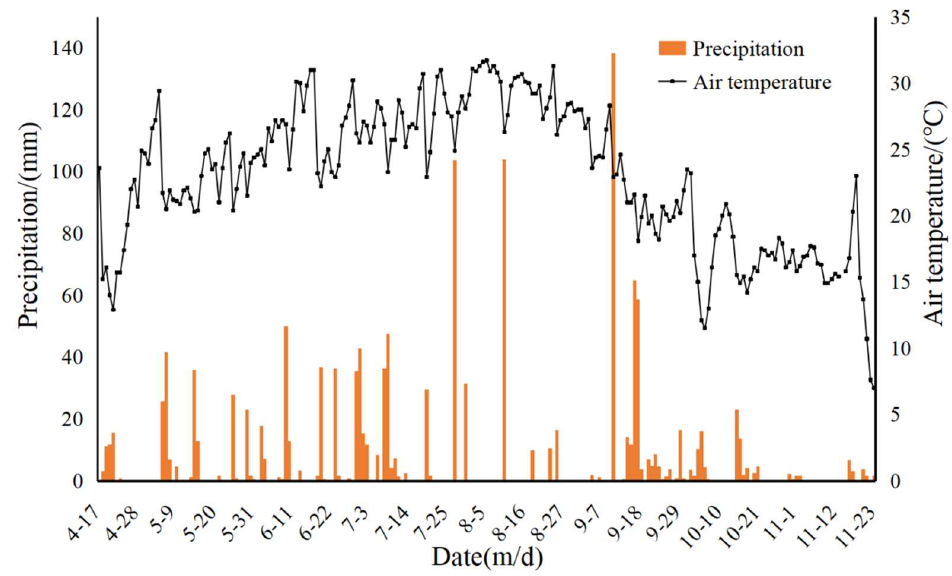
Table 1. The original soil characteristics (0–20 cm).